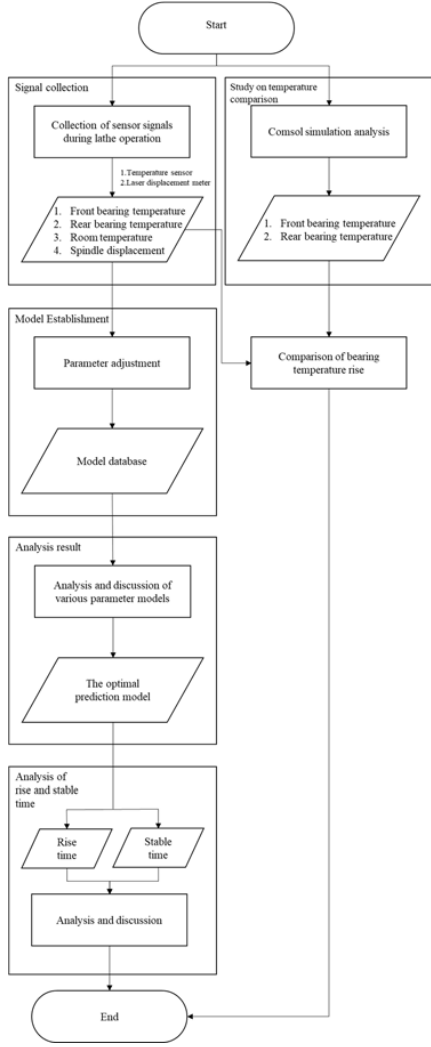
Figure 2. Study flow chart.